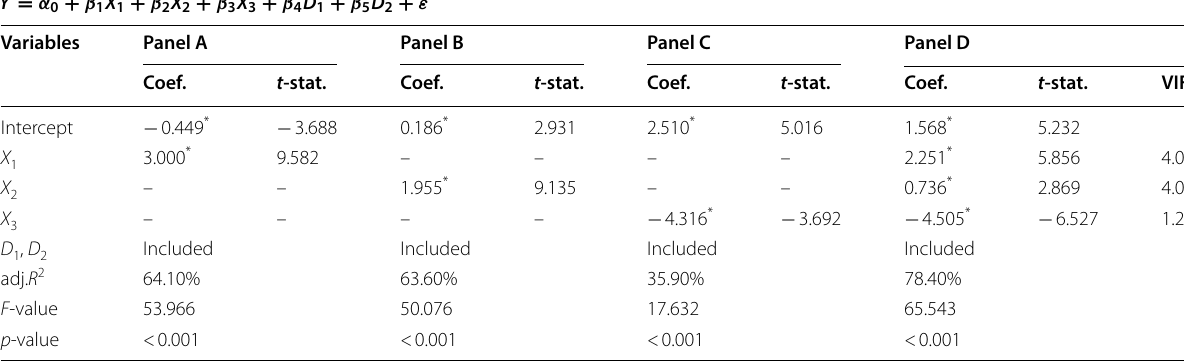
* Represents significance at 1 percent level. Denotations of variables are the same as in Table